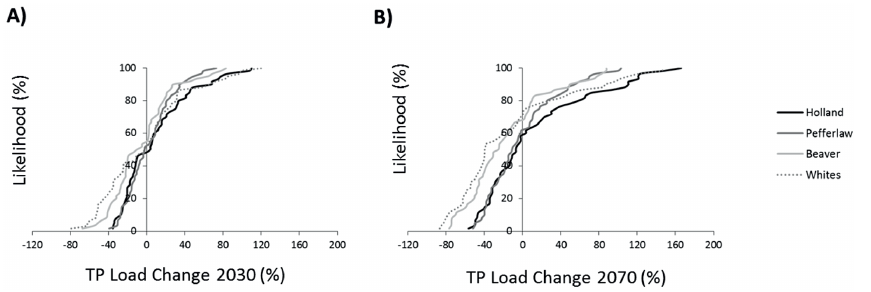
Figure 11. Between-catchment comparison of the CDFs from the perturbed physics ensemble of (a) change in total phosphorus loads (TP) by 2030, (b) change in TP loads by 2070 (CDF: cumulative distribution function).